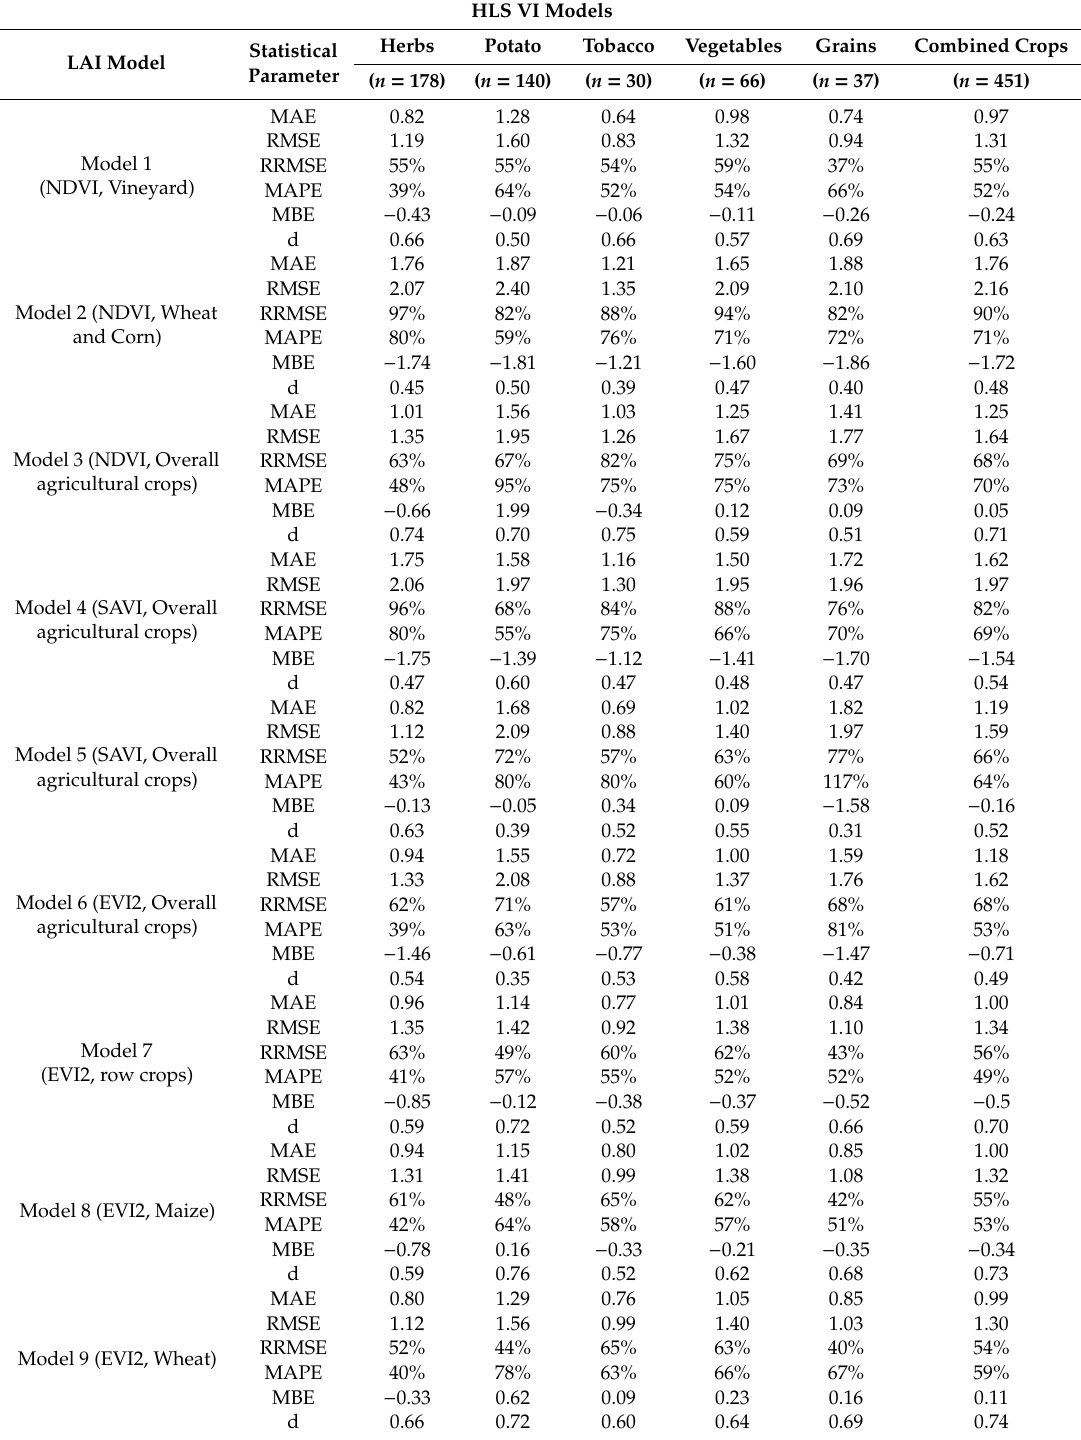
Table 4. Statistical analysis summary for the studied crops in both 2018 and 2019 growing seasons for the vegetation indices derived from the HLS product